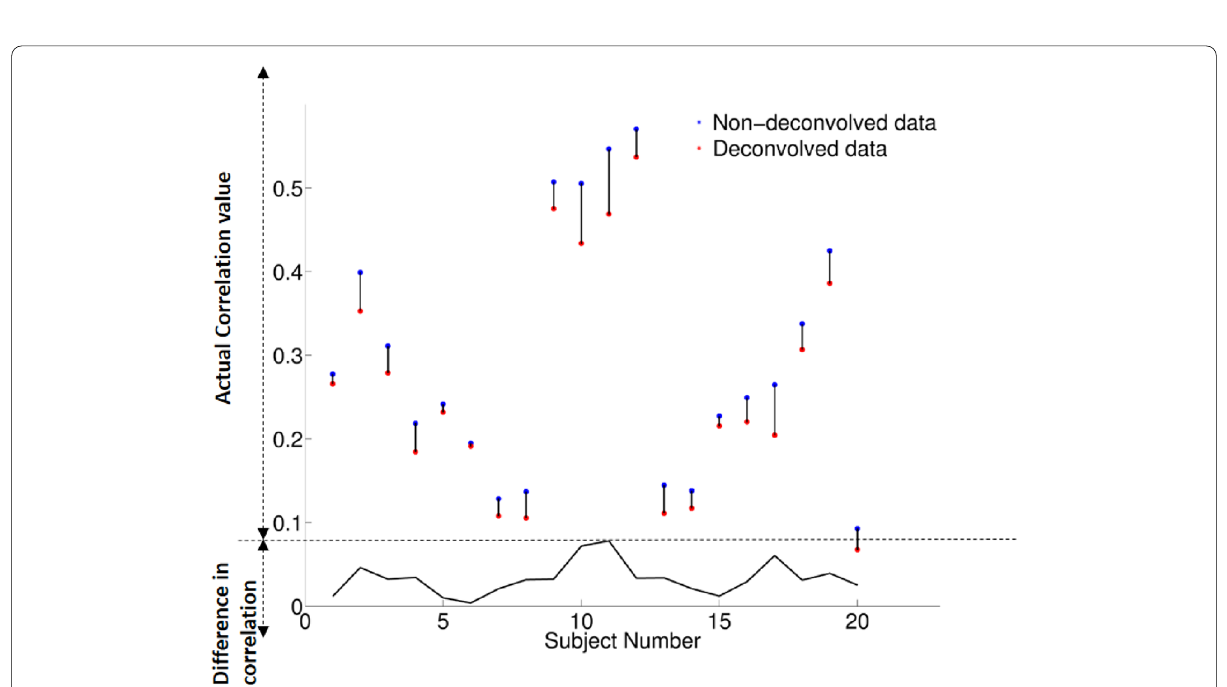
Fig. 7 Comparison of the individual-level average FC values before and after deconvolution for all paths. Blue represents FC values with non-deconvolved data, and red for FC values after